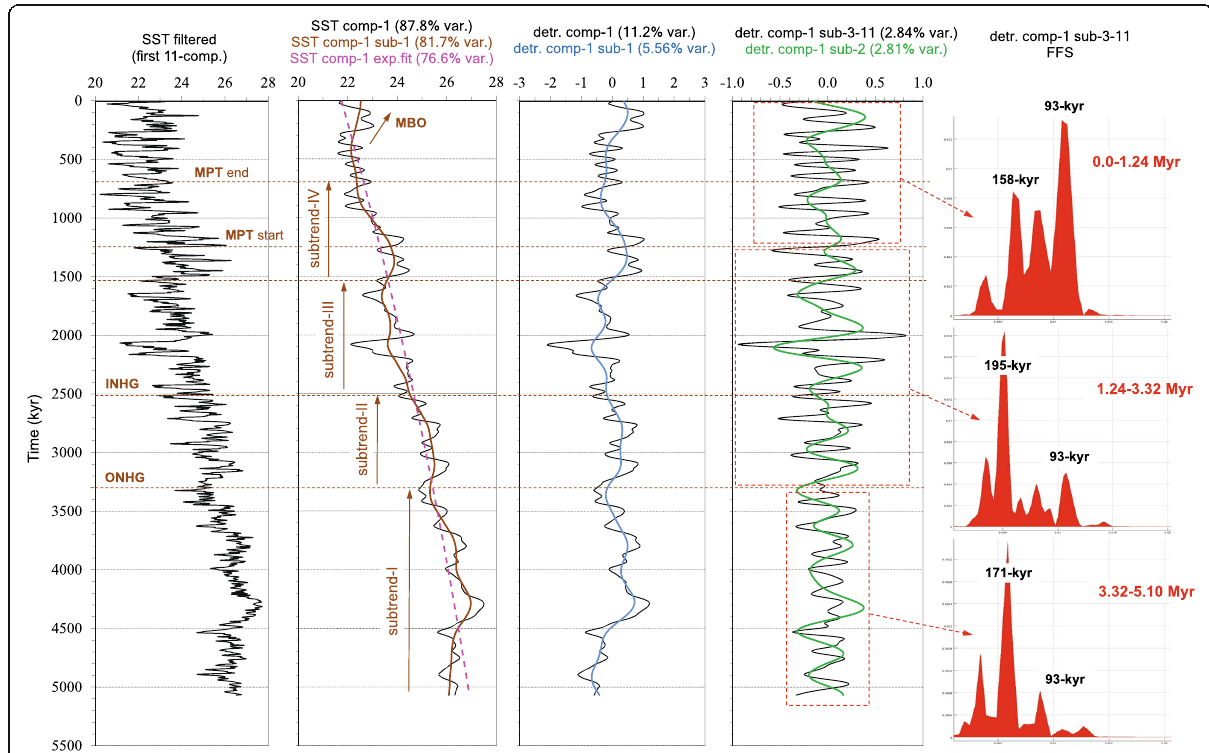
Fig. 6 Time-series panel of the ODP Site 846 SST component-1 and its subcomponents isolated by singular spectrum analysis. SST comp-1 exponential trend (°C) = 33.58041 – 11.84075 e ( − t /8830.503) . The vertical brown arrows show four subtrends of component-1 and their correlation to the NHG transitions known in the literature (MBO this study). To the right, Fourier frequency spectrum of SST detrended comp-1 subcomp-3-11 (2.84% variance) for three time intervals are highlighted by red boxes. Note the increase in amplitude after the ONHG (but not after the MPT) and the power increase of the ~ 93-kyr eccentricity cycle. x -axis scale variable (°C). The y -axis scale of the frequency spectrum increases upwards.